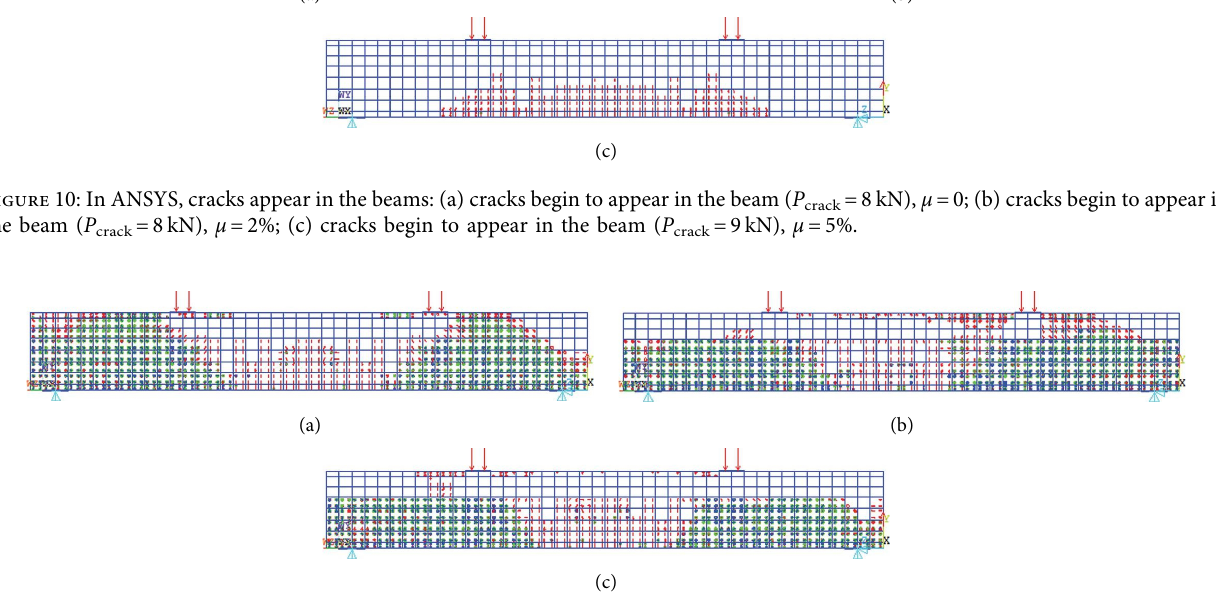
Figure 11: In ANSYS, beams quickly start to sufer from damage: (a) damage to the beam begins to appear ( P (b) damage to the beam begins to appear ( P max � 125kN), μ � 2%; (c) damage to the beam begins to appear ( P max � 116kN), μ �